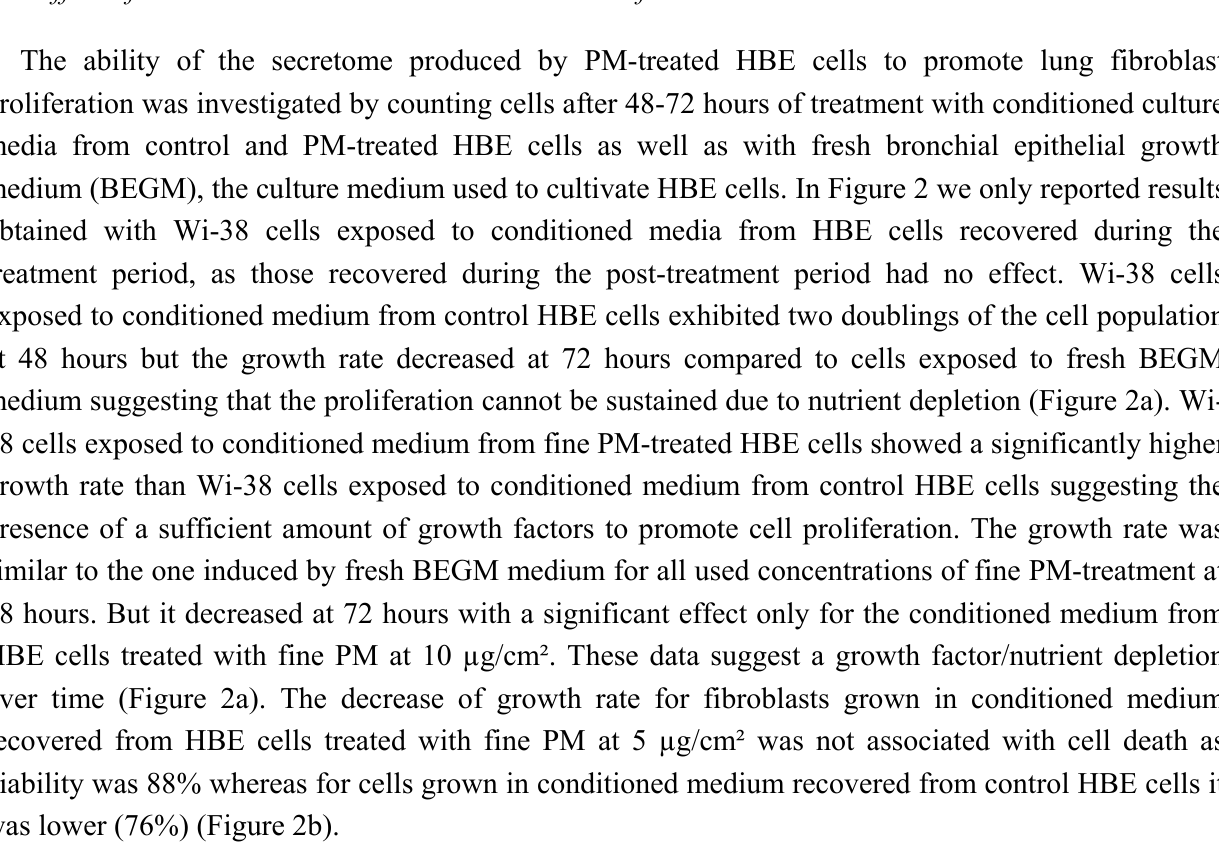
Figure 2. Effects of conditioned media on fibroblast (Wi-38) proliferation. Wi-38